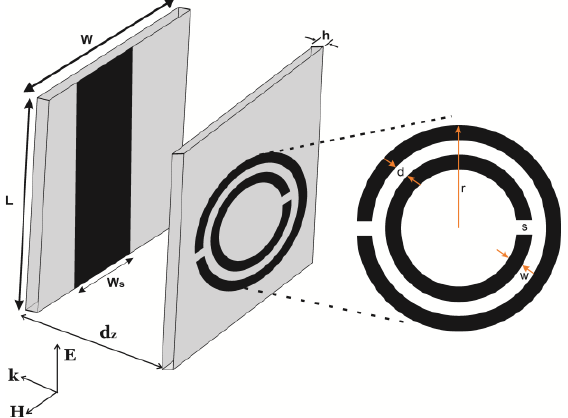
Figure 1: Unit cell of the SRR-wire pair